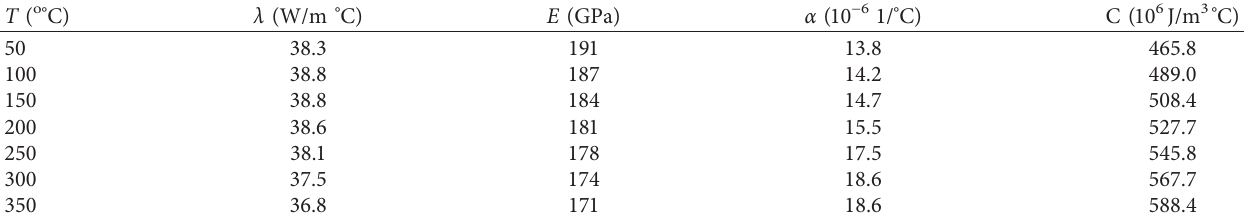
Table 1: Thermomechanical properties of the RPV material.